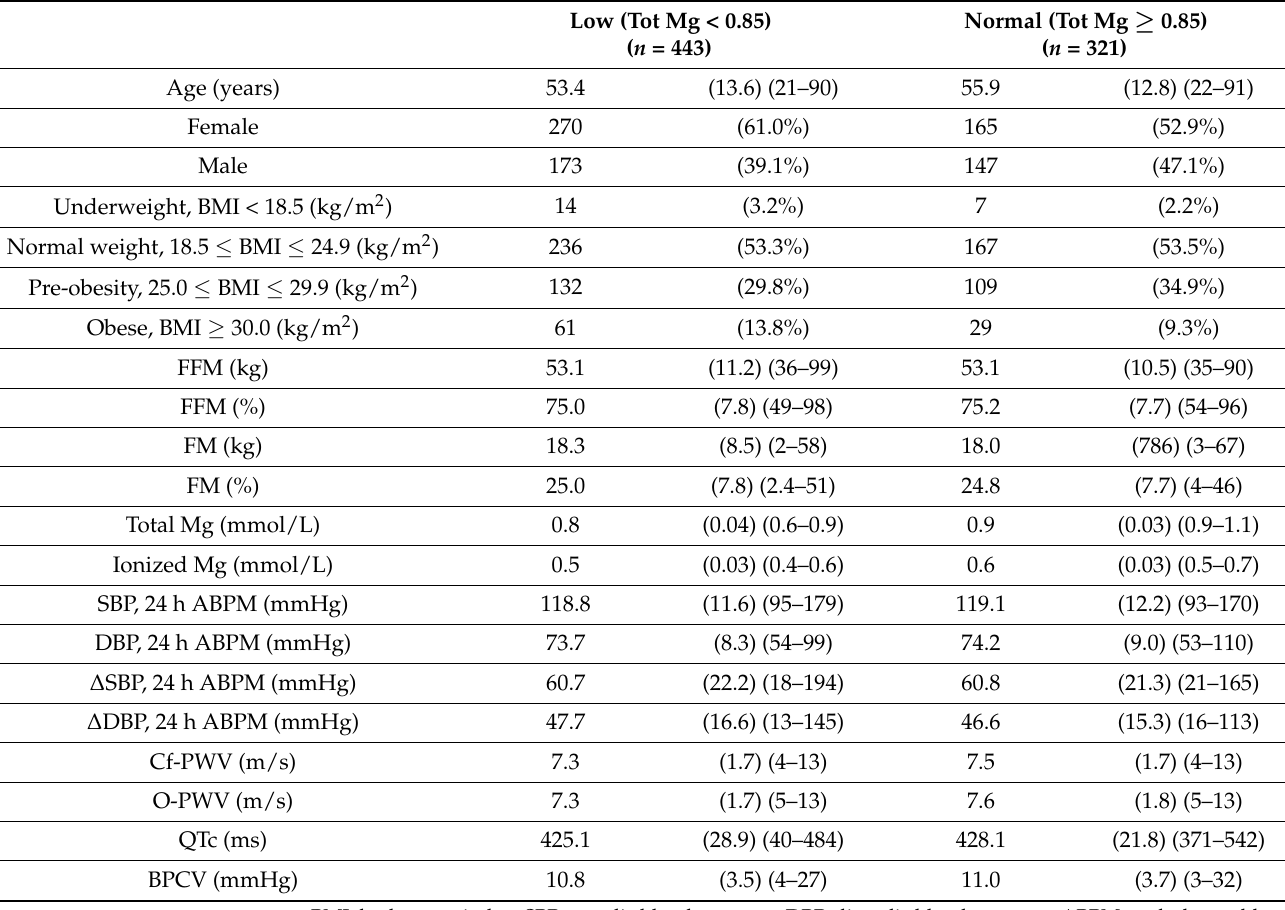
Table A5. Patients’ characteristics—Classification 2 Total Magnesium.